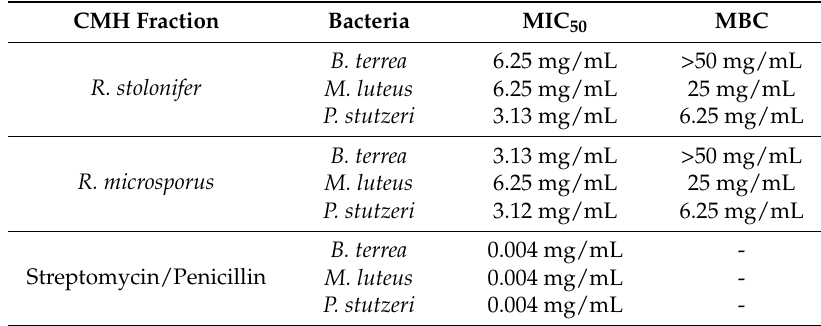
Table 2. Minimum Inhibitory Concentration (MIC) and Minimum Bactericidal Concentration (MBC) values from CMH of R. stolonifer and R. microsporus grown in PDB media. MIC values from Streptomycin/Penicillin as a drug control. CMH Fraction